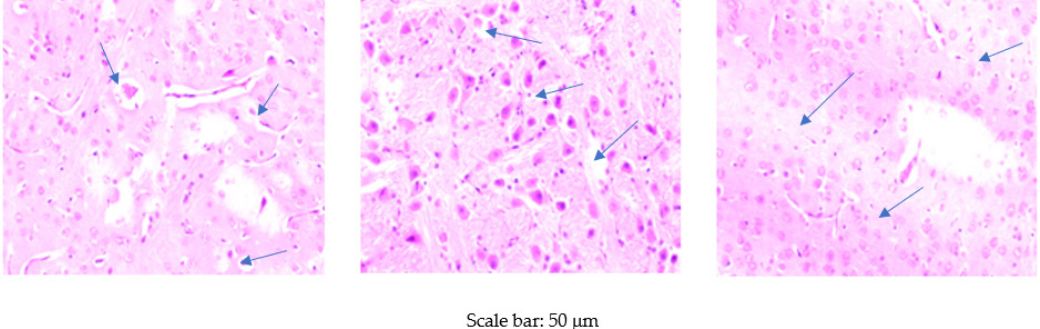
Figure 1. Morphological effects of high-fat diet and different Cr sources on rat brain. Foci of vacuolar degeneration of varying severity observed in all experimental groups, except the group receiving the standard diet without Cr supplementation (magnification 100×).